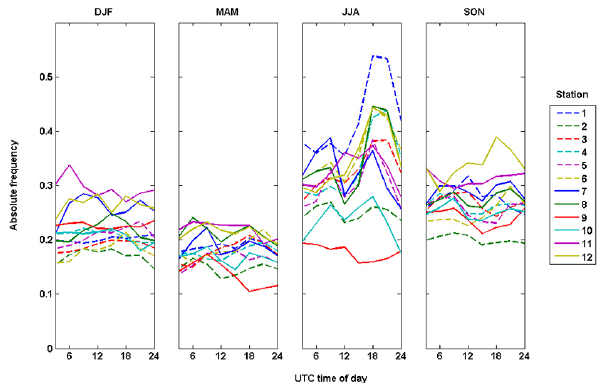
Figure 2. Diurnal cycle of total precipitation for the 12 radar sta- tions and its seasonal variation. The values on the x axis are UTC